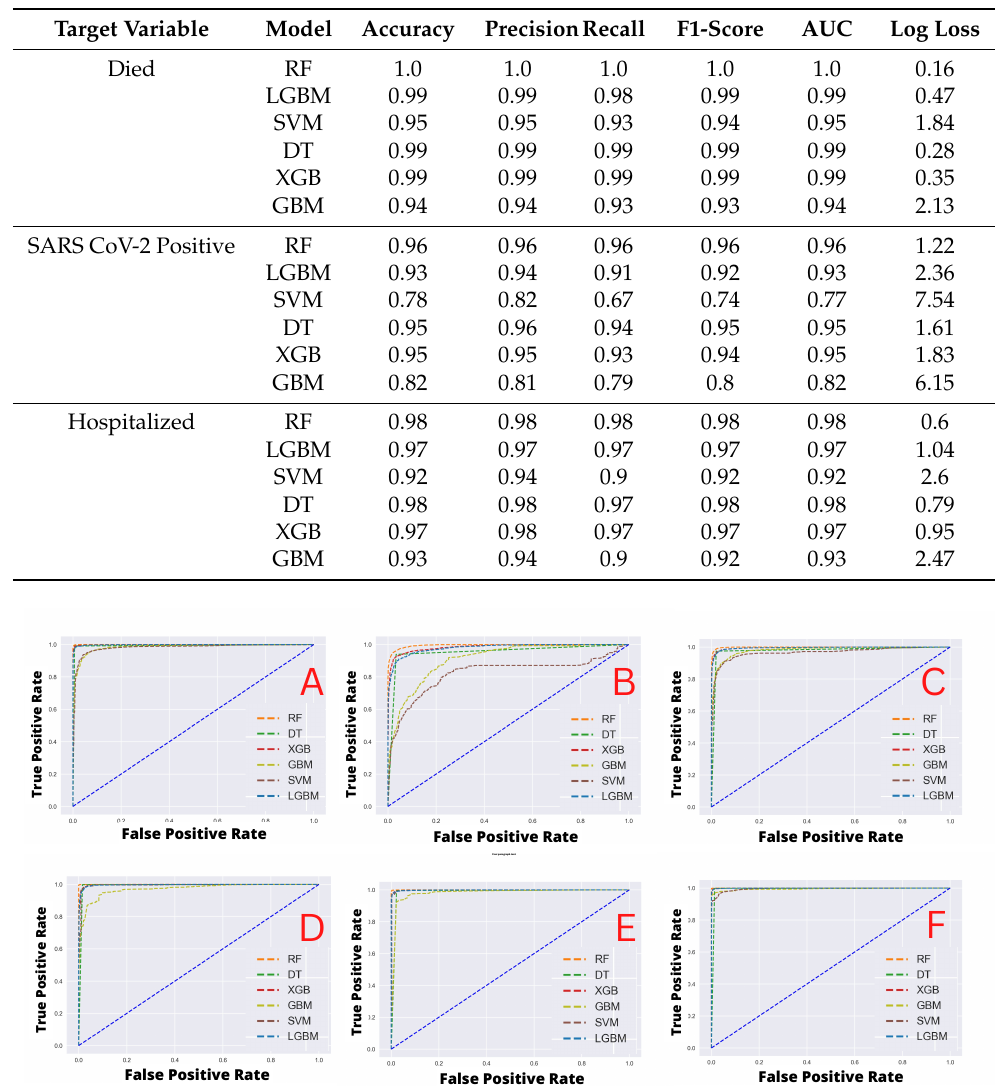
Table 3. Comparative performance evaluation for the patient classification based on machine learning algorithms with the dataset of patients’ medical history.